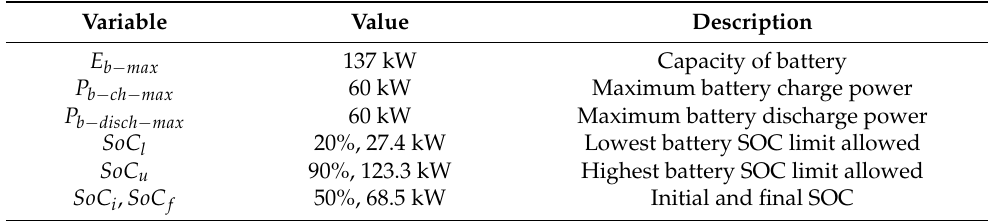
Figure 3. Diagram overview of rule-based peak shaving model. The input variables are presented and explained in Table 5. Table 5. Variables for rule-based control.